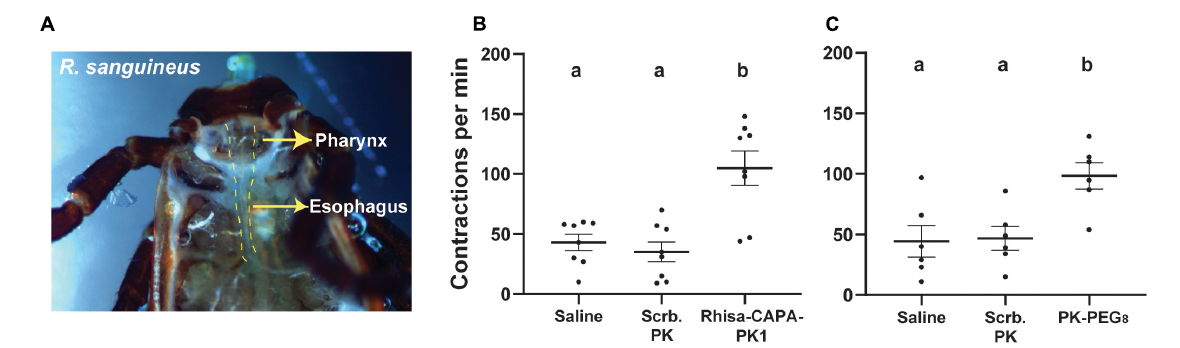
FIGURE 2 | Rhipicephalus sanguineus feeding tissue contraction assay. (A) Unfed female R. sanguineus ticks (2- to 3-month-old) were dissected under tick physiological saline to expose the pharynx-esophagus. Tick endogenous pyrokinin (B) and PK analog (C) increase the contractions of the pharynx-esophagus: After dissection, ticks were transferred to a Sylgard plate into fresh saline (100 µ l). After 5 min of adaptation to the environment, the solution was replaced with 100 µ l of saline, and tissues were filmed to register any background contractions. The solution was replaced by 100 µ l containing 10 µ M of a scrambled peptide of PK (RNFSRINTPa) as negative control and incubated for 3 min before the tissue response was filmed. Tissue was then rinsed (5 × 100 µ l of saline), and the saline was replaced with 100 µ l of tick endogenous pyrokinin (Rhisa-CAPA-PK1: RSNTFTPRIa), or a PK analog (1944-P8: MS[PEG 8 ]-YFTPRLa), both at 10 µ M. After 3 min of incubation, the tissue was filmed. Tissue responses to all treatments were filmed for a continuous 1 min using a Lumenera Infinity-1 color camera (Teledyne Lumenera, Ottawa, ON, Canada) installed on an Olympus SZ61 trinocular stereo microscope (Olympus, Center Valley, PA, United States), and contractions in the video were counted by the same operator (mean ± SEM). A repeated measures one-way ANOVA analysis ( P < 0.05) followed by a Tukey’s multiple comparisons test were performed to determine the difference in response to different treatments on the same tick ( N = 6–7 ticks); different letters in the figure indicate significant difference, P <